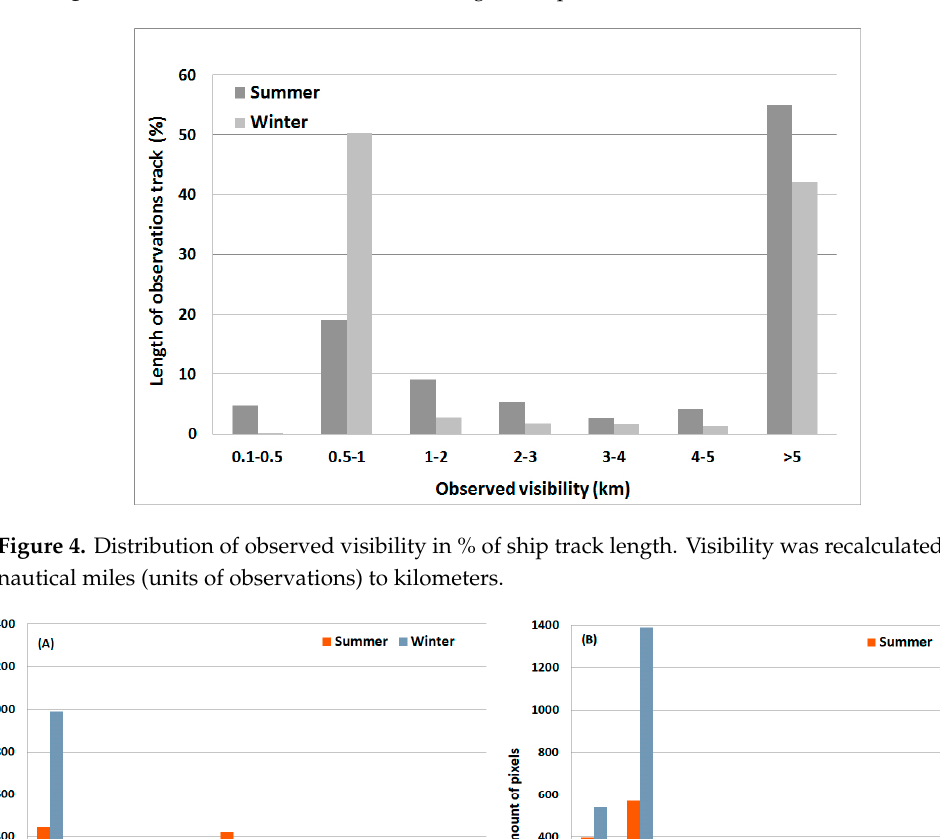
Figure 4. Distribution of observed visibility in % of ship track length. Visibility was recalculated from nautical miles (units of observations) to kilometers.